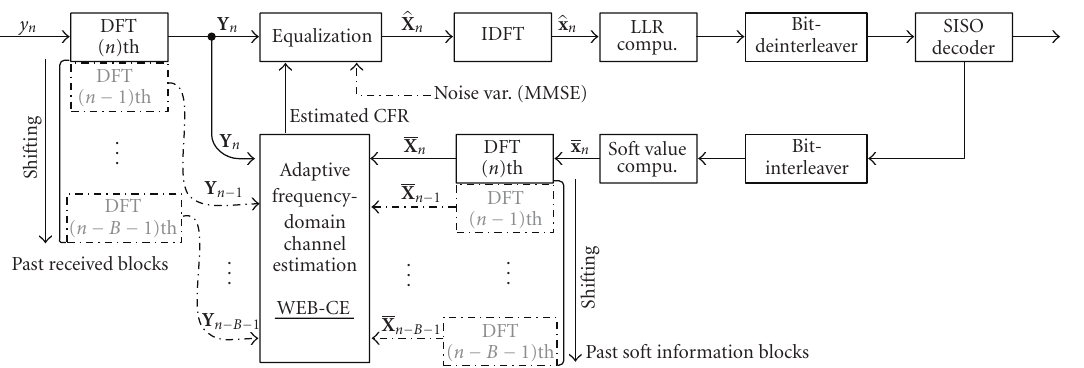
Figure 2: Iterative receive structure employing the WEB-CE when the iteration number is greater than one. Dotted blocks correspond to registers (or bu ff ers) preserving the past information.